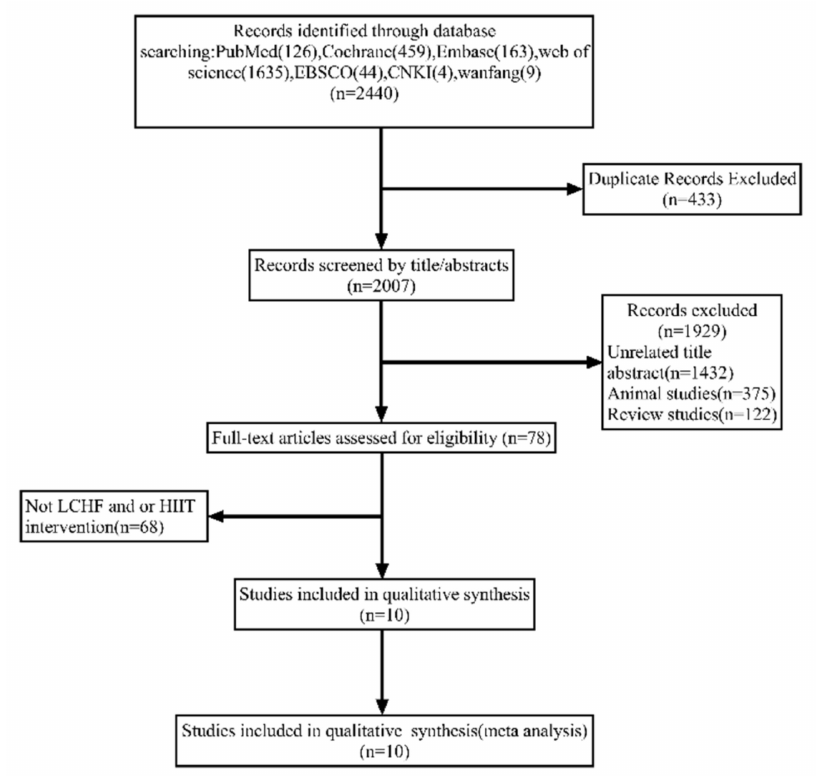
Figure 1. Flow diagram of the study selection